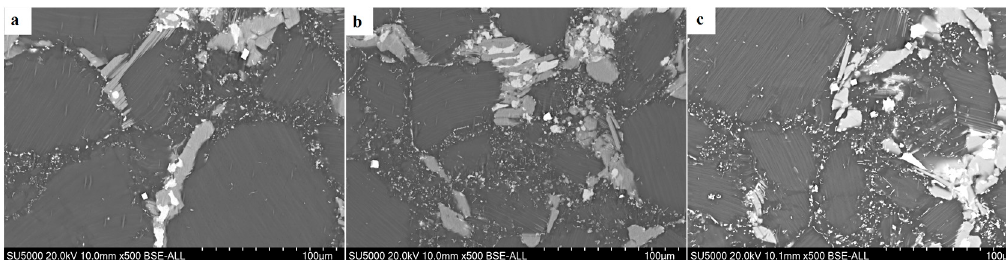
Figure 11. ( a – c ) BSE images of the center, middle, and edge of the strain rate of 0.001 s − 1 , respectively.